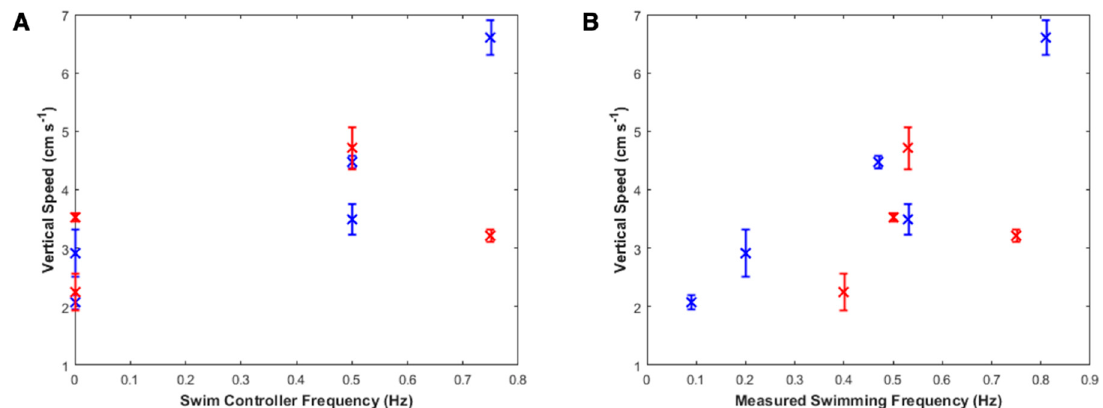
Figure 6. Vertical swimming speeds. ( A ) Vertical swimming speeds over swim controller frequency, the externally driven frequency set by the robotic system. Each animal is represented by a different color (blue or red). Two control measurements were taken for each animal (at 0 Hz), and two videos were recorded at 0.50 Hz for animal 1 (blue). ( B ) Vertical swimming speeds over measured swimming frequency, the summation of both the externally driven frequency set by the robotic system and the animals’ own native pulses. Each animal is represented by a different color (blue or red). Variations in the animals’ baseline frequency can determine limits for robotic manipulation.